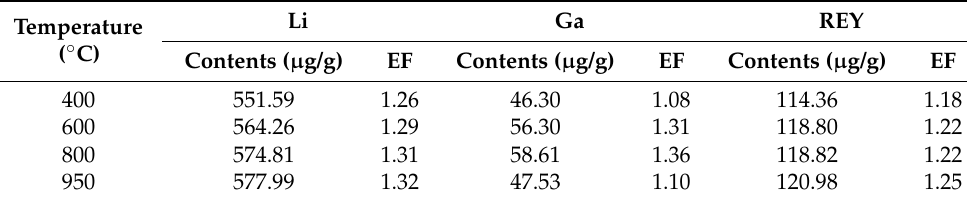
Table 4. Content and enrichment factor (EF *) of Li, Ga, and REY in different calcined coal gangues.